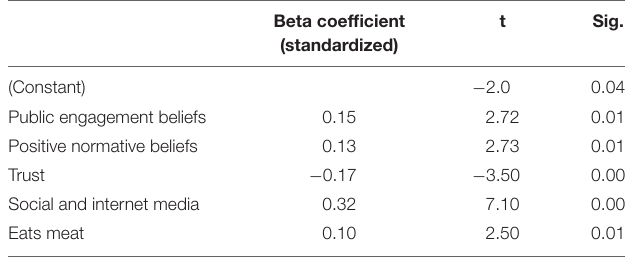
TABLE 9 | Linear regression with Community behavior as the dependent variable and all composite variables entered listwise as the predictors, for the PANEL